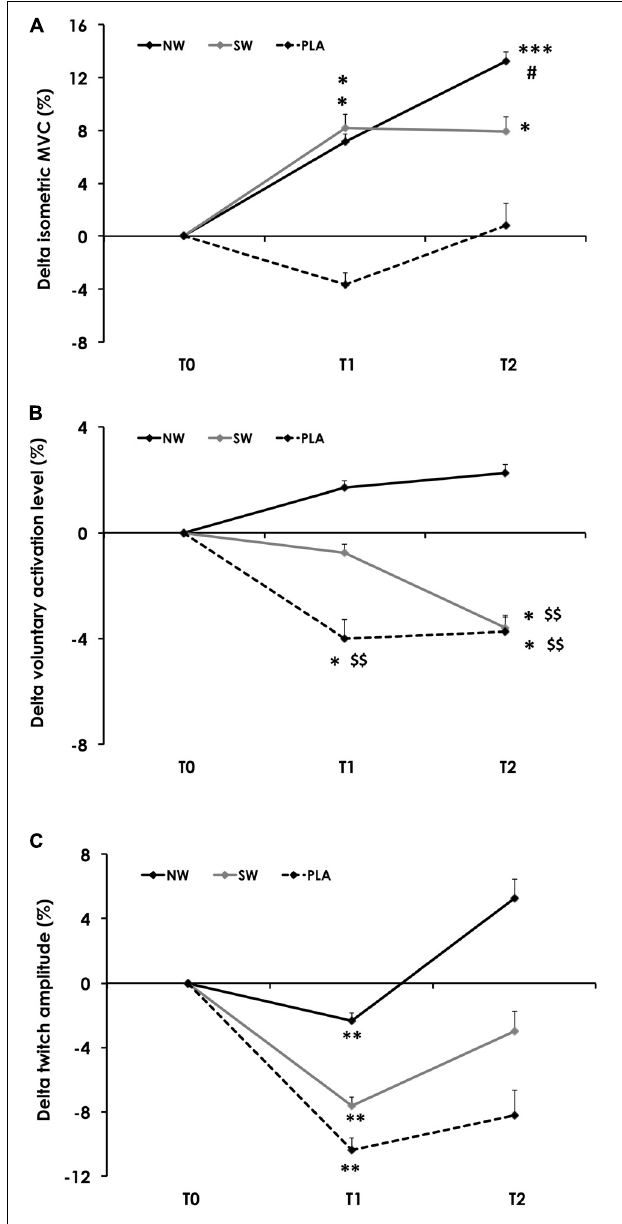
FIGURE 2 | Variation of the isometric maximal voluntary contraction torque (MVC; A ), voluntary activation level (VA; B ) and twitch amplitude (C) during the training program. Variables were measured before (T0), and after 6 (T1) and 12 weeks (T2) of training. For the sake of clarity, values are expressed as the relative variation from T0. Significantly different from T0: ∗ p < 0.05, ∗∗ p < 0.01, ∗∗∗ p < 0.001. Significantly different from T1: # p < 0.05. Significantly different from NW: $$ p <